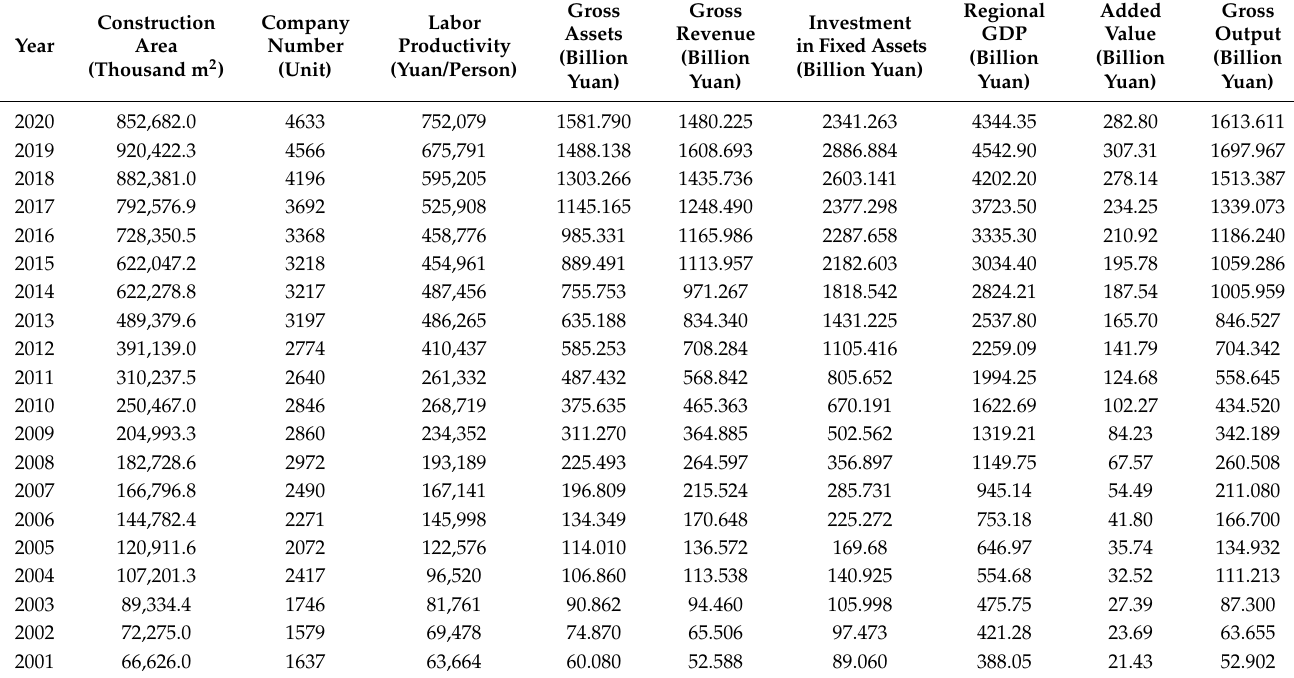
Table 3. Raw data of gross output and relevant indexes of the construction industry in Hubei from 2001 to